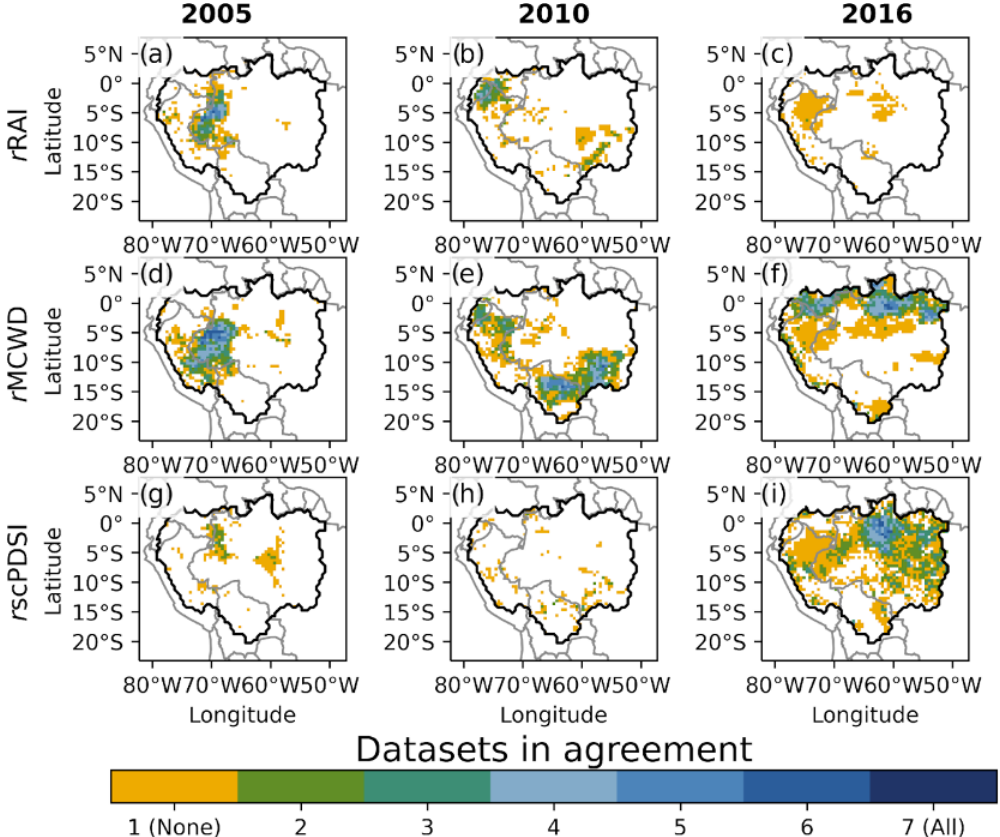
Figure 5. Agreement of precipitation datasets on drought area as identified by different drought metrics. Comparison of the Amazon drought events in 2005, 2010 and 2016 (columns) vs. three different drought indexes (rows): (a–c) rMCWD, (d–f) rscPDSI and (g–i) rRAI. Only the area affected by severe drought stress is displayed, which is defined equally for each of the drought indices. Orange pixels indicate areas where only one dataset shows the respective drought stress (“None”). White pixels represent areas where no dataset shows any drought